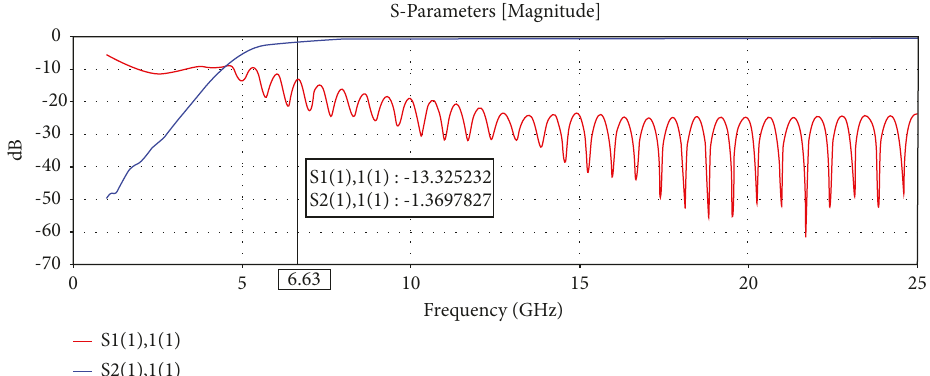
Figure 5: Refection coefficient and transmission coefficient for a circular dielectric rod with a � 10mm and ε